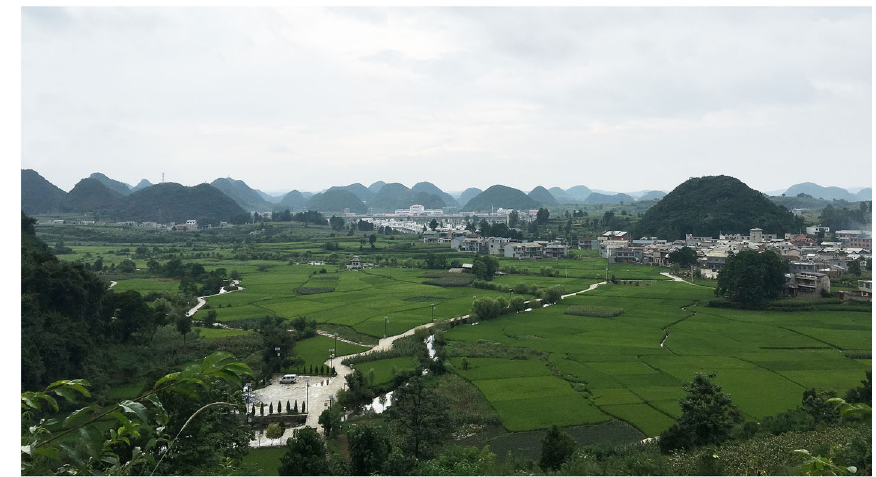
Fig. 2 Baojiatun Village on depressions surrounded by karst peaks (Source: the